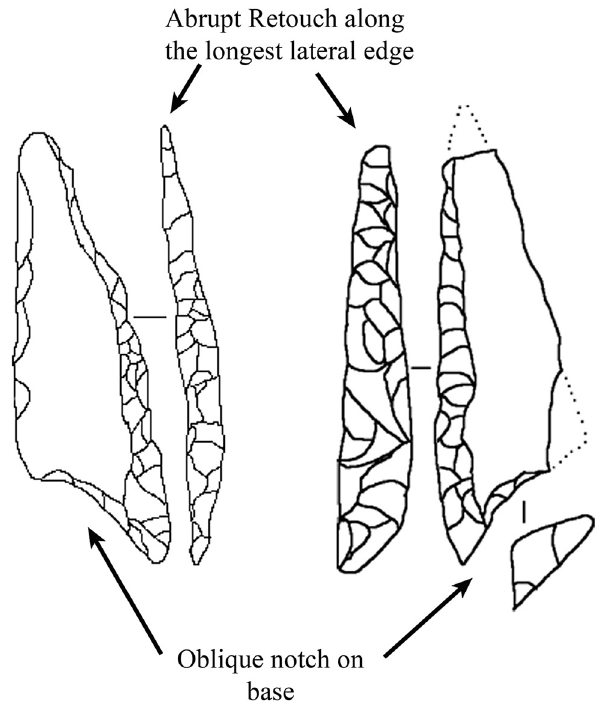
Figure 7: Direct comparison between a Bexhill point from SE England ( left ) and a similar point from Mendandia, N. Spain ( right )